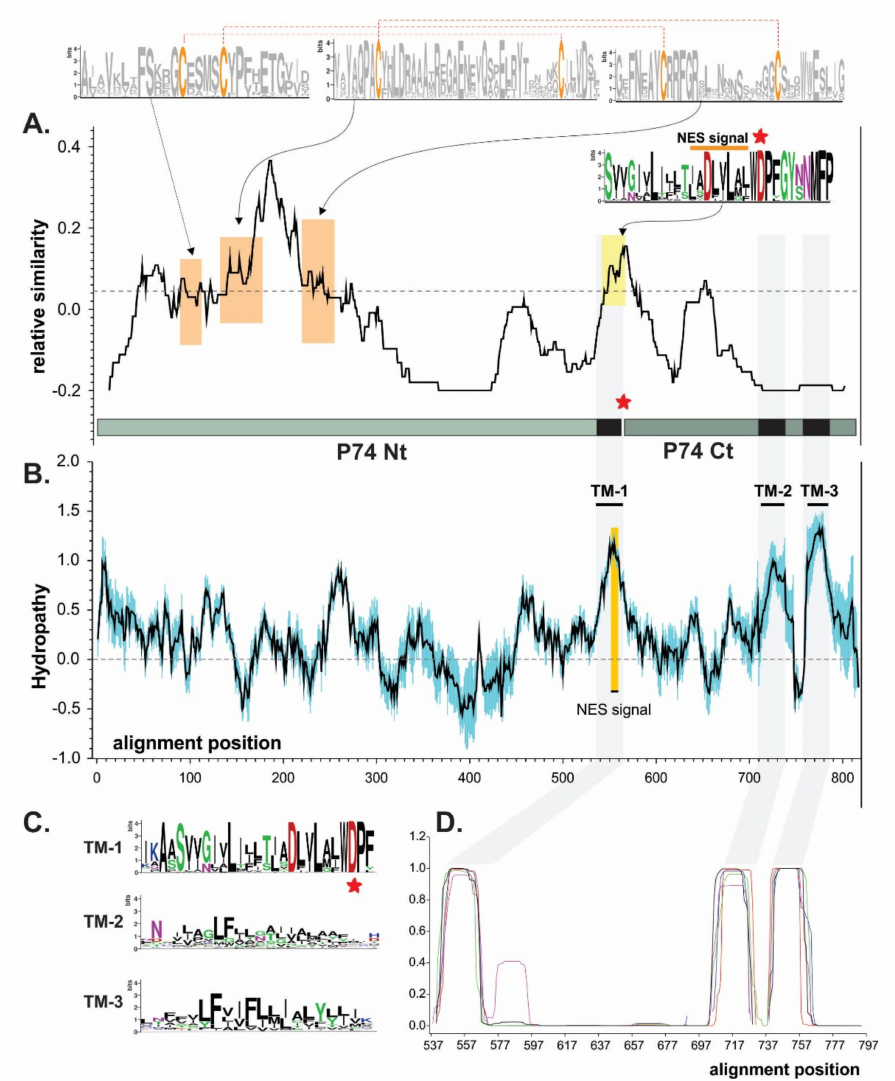
Figure 2. Domain architecture of P74 proteins. Bioinformatics studies for P74 protein consensus based on sequences from species of four baculovirus genera. ( A ) P74 similarity plot. The dashed line indicates the average value. Sequence logos highlight the six cysteines perfectly conserved in all P74 (orange boxes). Dashed red lines show the connectivity predicted with Disulfind server. The putative NES is also indicated (yellow box), and the point of separation between the Nt and Ct regions is marked with a red asterisk. The WDP triad contains a conserved BamH I site at the nucleotide sequence level (or the possibility of introducing it through a same-sense point mutation) further used on the construction of hybrid proteins. ( B ) P74 hydropathy profile (black line). Variability was considered as the standard deviation (in blue). The three putative transmembrane regions (TMs) are indicated, with one of them (TM-1) containing a putative NES sequence. ( C ) Sequence logos of each of the TM detected. ( D ) TM predictions. These regions are highlighted in gray in all